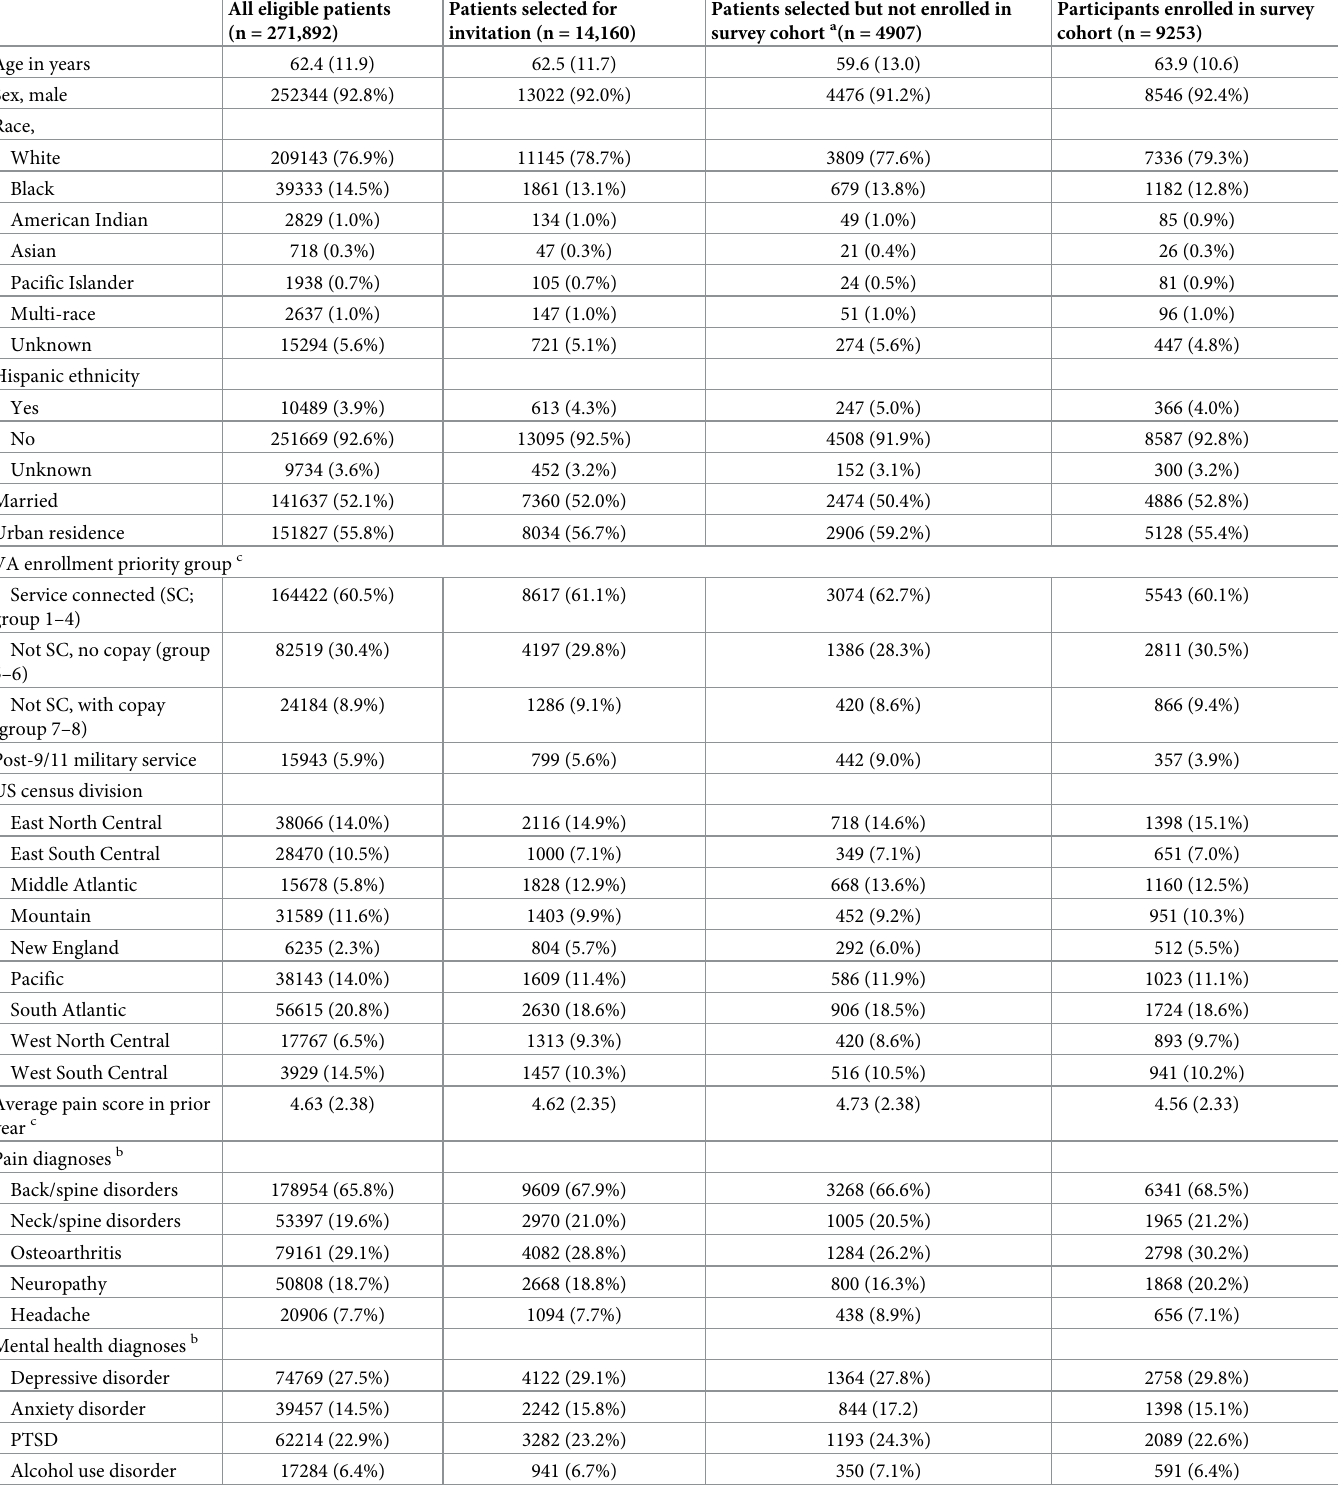
Table 1. Characteristics of EPOCH-eligible patients by study participation status at index